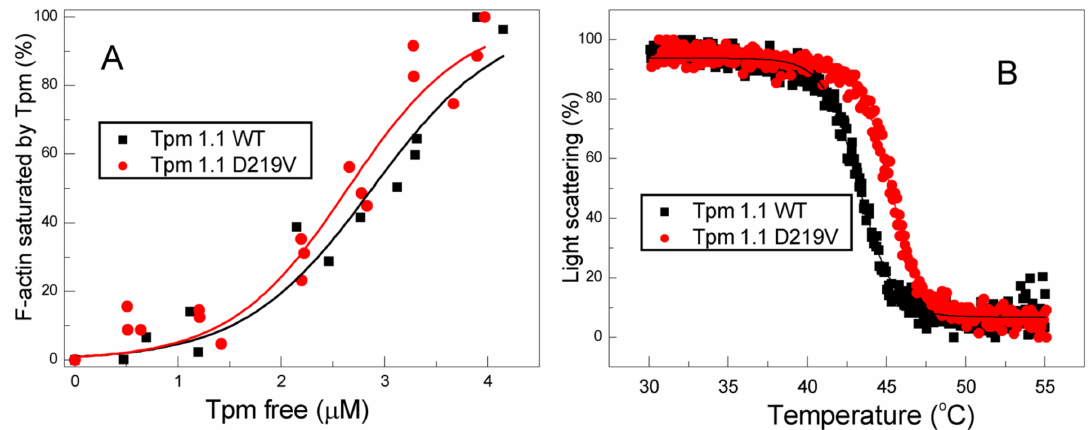
Figure 3. The effect of the D219V Tpm mutation on the Tpm affinity for F-actin was estimated by the co-sedimentation assay ( A ), and the thermal stability of the Tpm-actin complex was determined by light scattering ( B ).